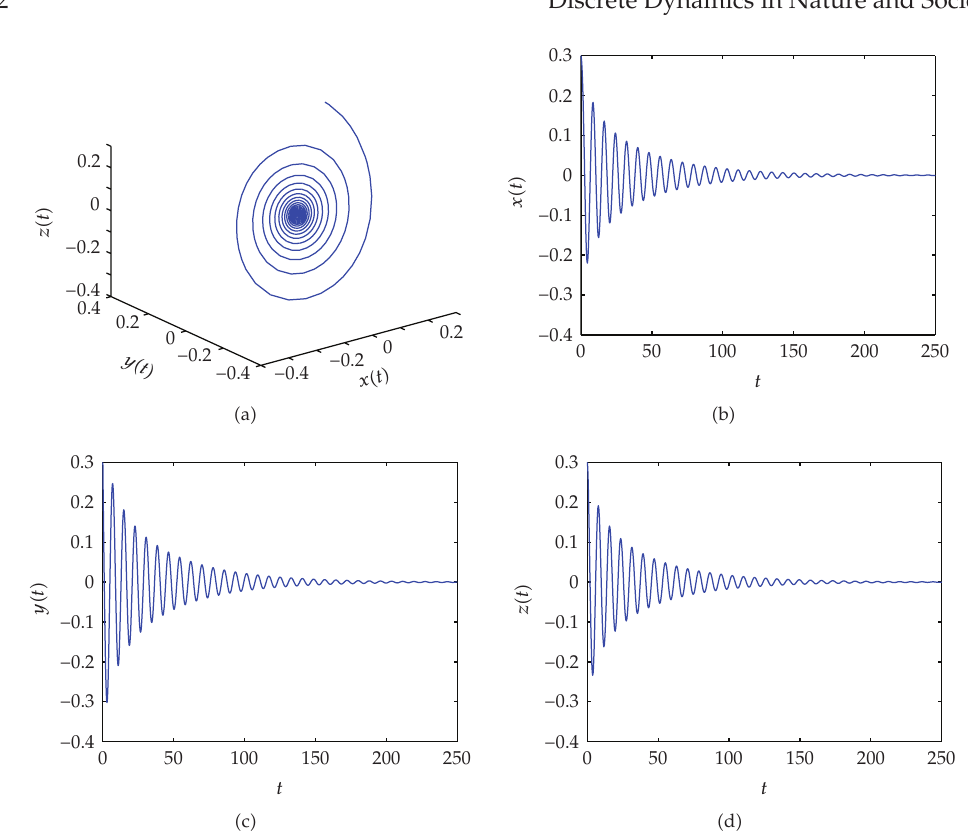
Figure 1: Phase portrait and waveform portraits of system (cid:4) 2.2 (cid:5) with τ (cid:6) 0 .